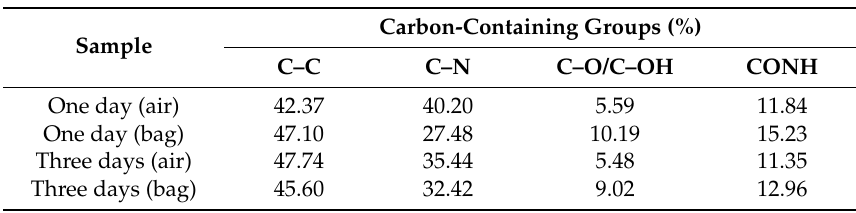
Relative amounts of different carbon-containing groups (%) with storage time and environment varying.